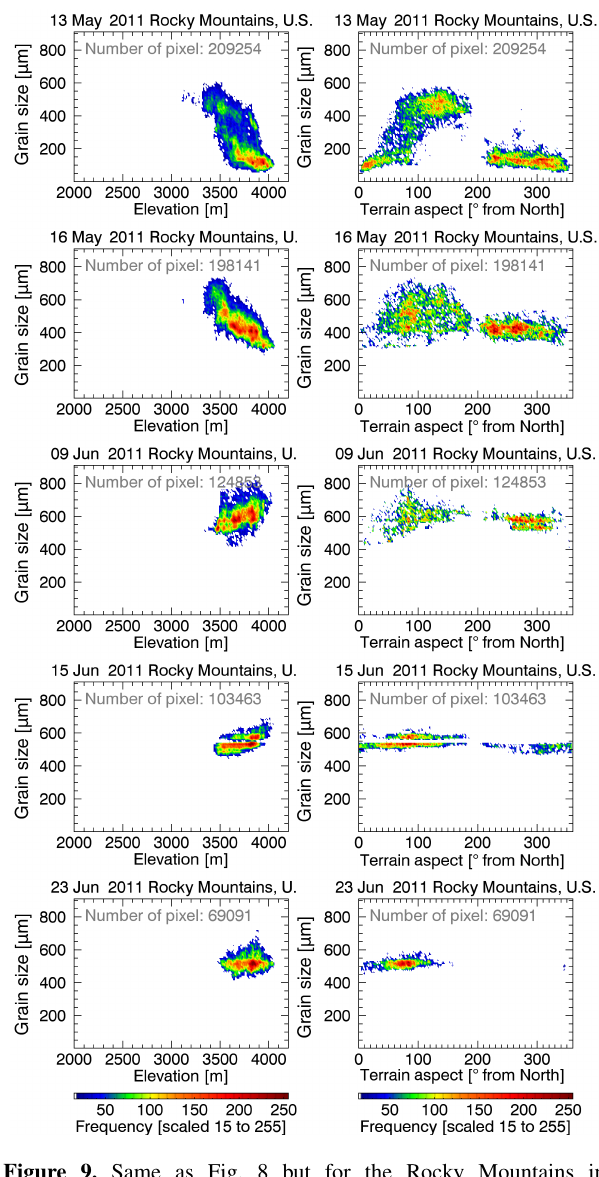
Figure 8. Two-dimensional histogram of snow grain size with re- spect to terrain elevation (left panels) and aspect (right panels) in the Sierra Nevada in spring 2009.